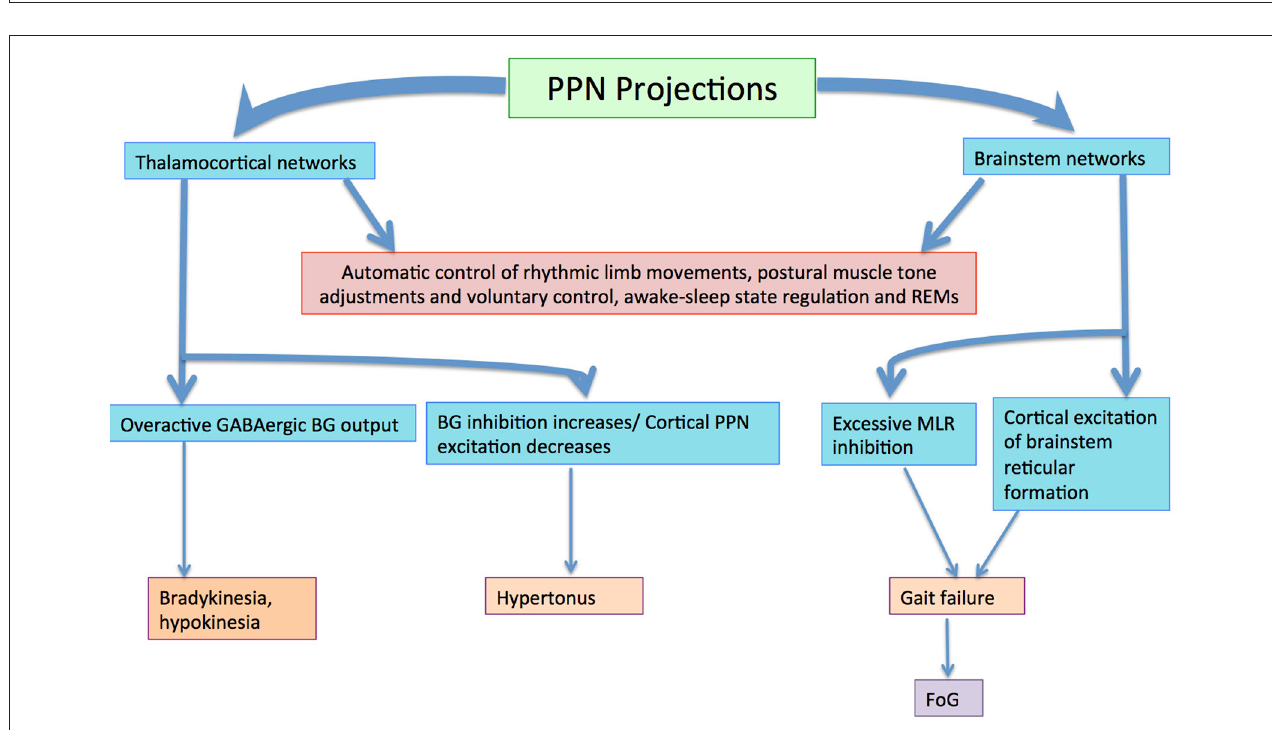
FIGURE 5 | The involvement of the PPN in the neuropathology of